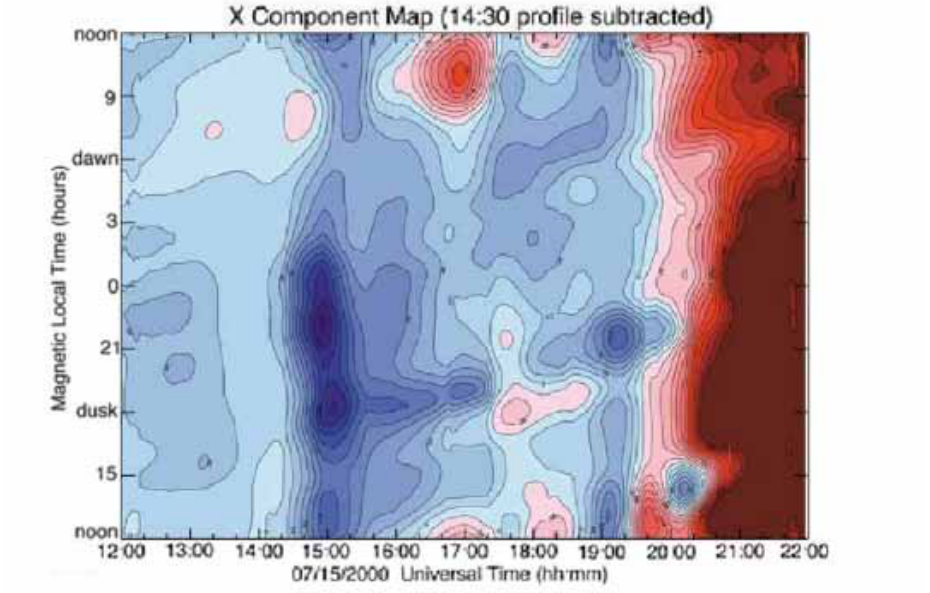
Fig. 14. Magnetic Local Time (MLT) versus Universal Time (UT) map showing the H -component magnetic disturbance field obtained from middle- and low-latitude ground-based magnetometers on 15 July 2000. The contours show a magnetic disturbance at 19-nT intervals with the subtracted quiet time variations (at 14:30 UT), with positive perturbations shaded in blue and negative ones shaded in